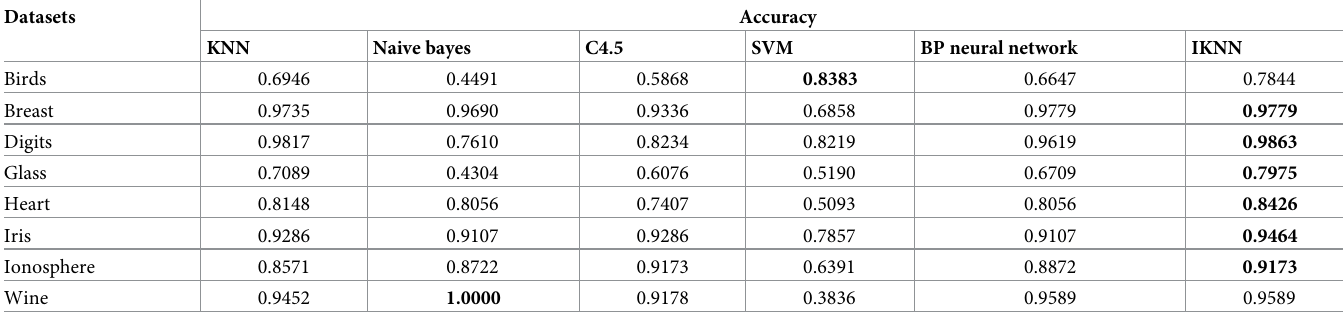
Table 8. The comparison of classification accuracy of different classifiers.